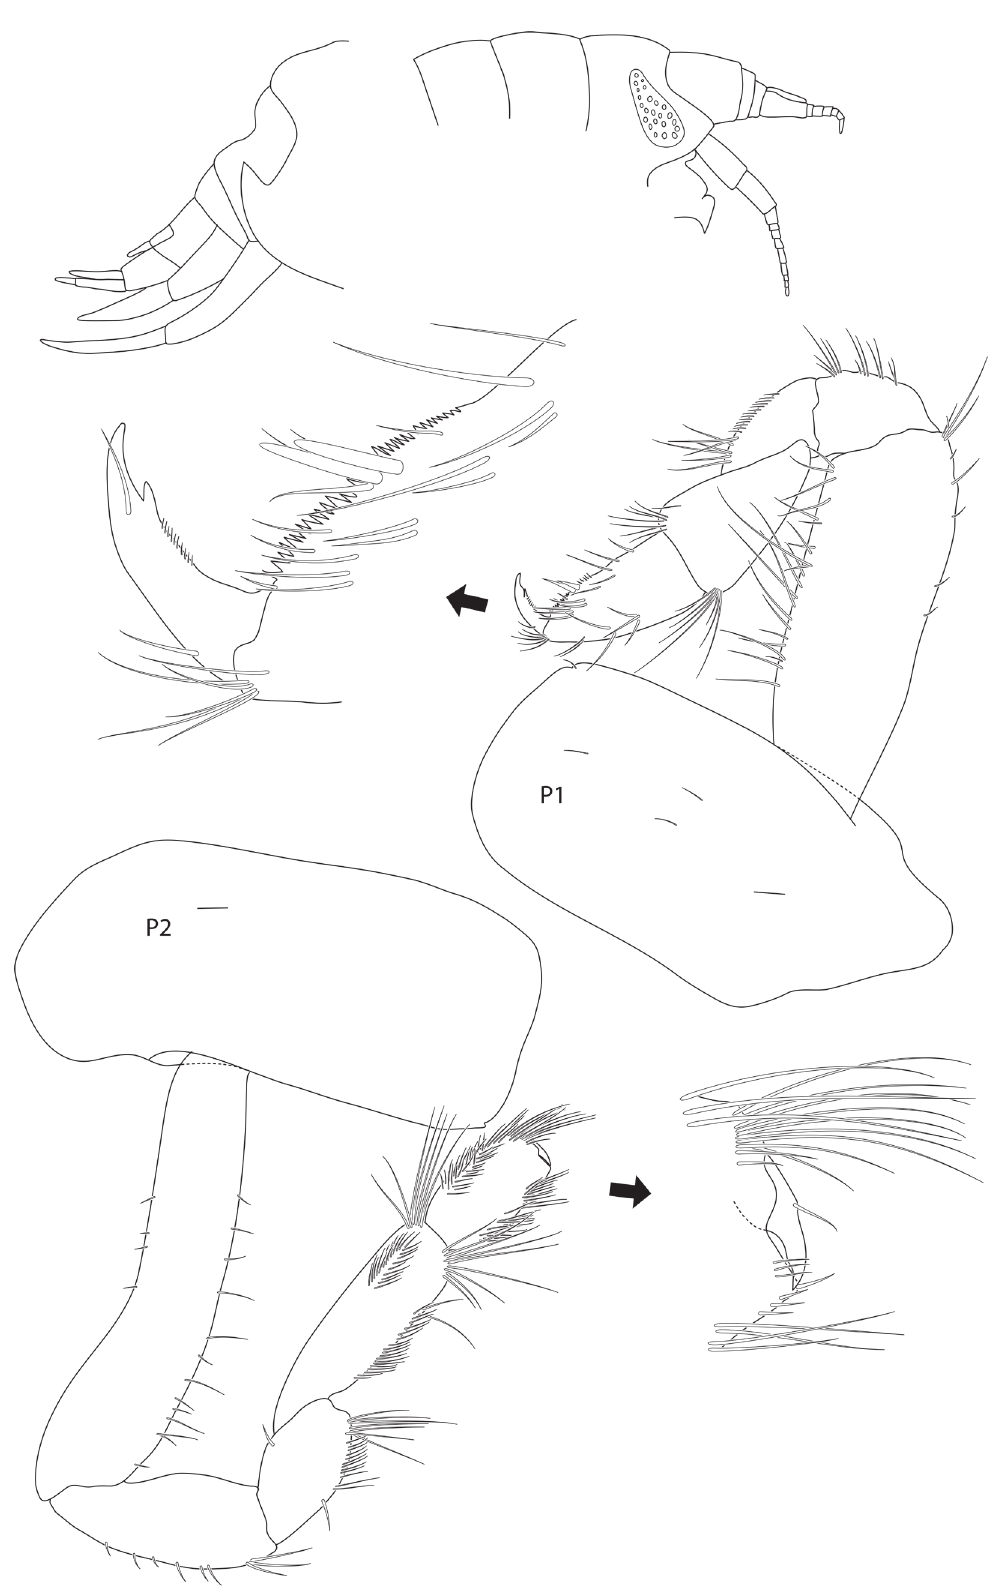
Fig. 8. Onisimus turgidus (Sars, 1879), ♀, 10 mm, Ullsfjorden (100 m depth) (TSZCr8573). Head, backbody, pereopods 1–2. Abbreviations: see Material and methods. Scale bars = 0.1